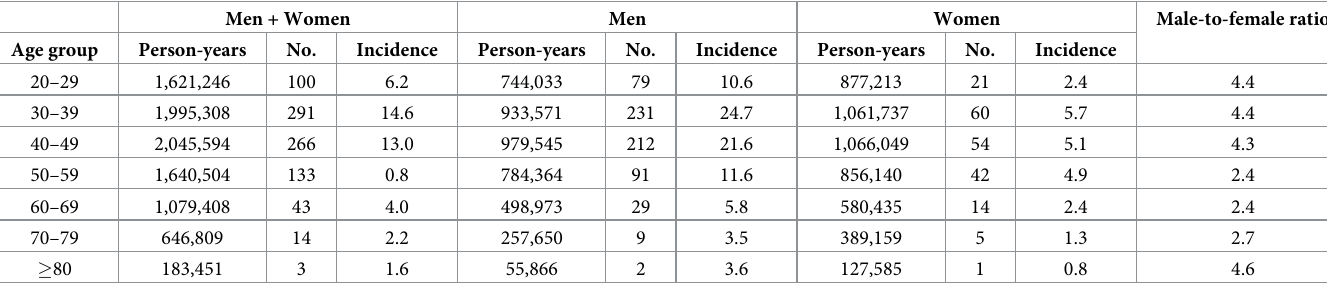
significantly higher, compared with the control group (Fig 2). However, daily temperature ranges were not significantly different in the two groups. In addition, there was no significant group difference in residential latitude and higher household income was also associated with Table 2. Incidence of achilles tendon repair per 100,000 person-years, grouped by